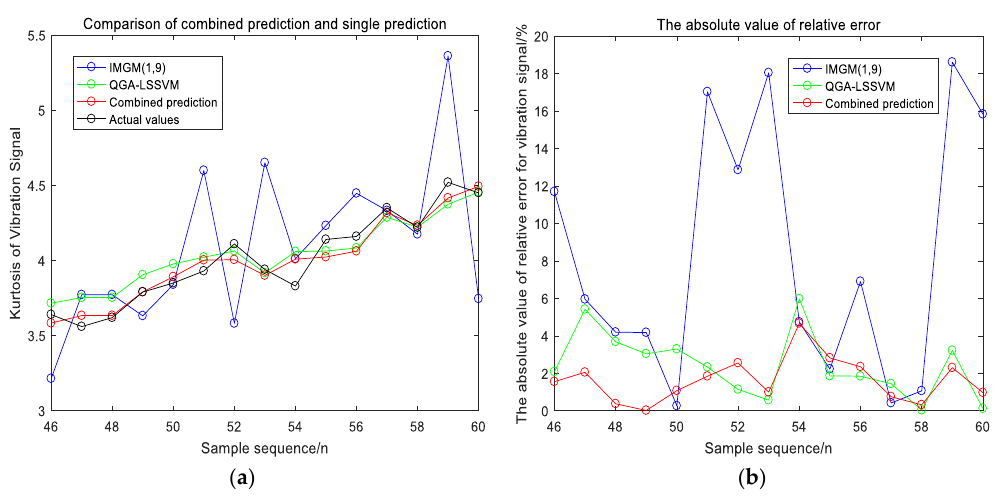
Figure 5. Comparison of the combined forecasting model and the single forecasting models for vibration signal. ( a ) The prediction result from the 46th points to the 60th points; ( b ) the absolute value of relative